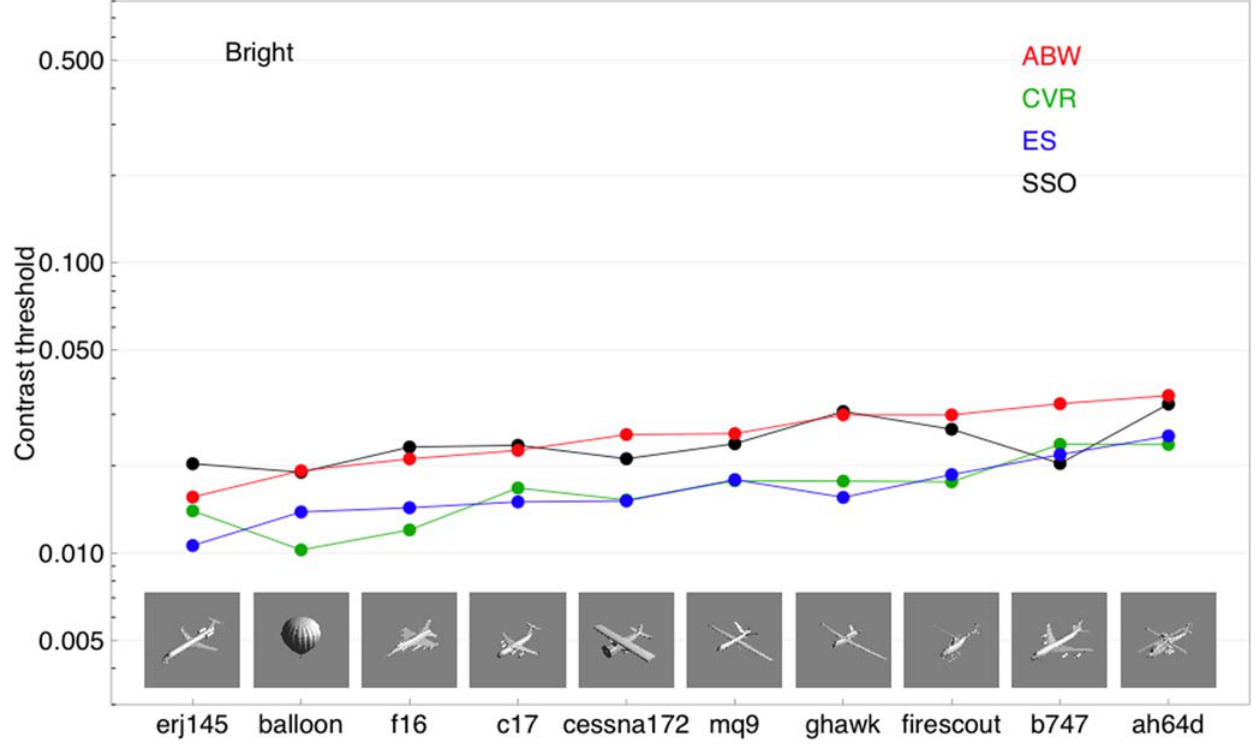
Figure 8. Contrast thresholds for three observers for ten different aircraft. All the aircraft have positive contrast (are brighter than the background). Actual aircraft images are shown in the figure. The black points are SSO predictions. The data are sorted from left to right according to the mean threshold for the three observers.